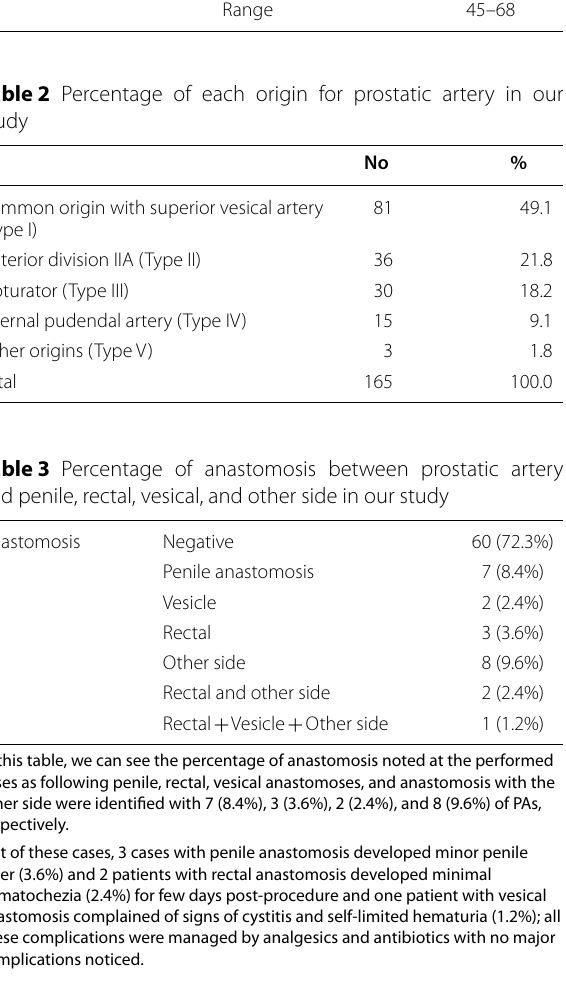
Table 4 Comparison between our study and De Assis et